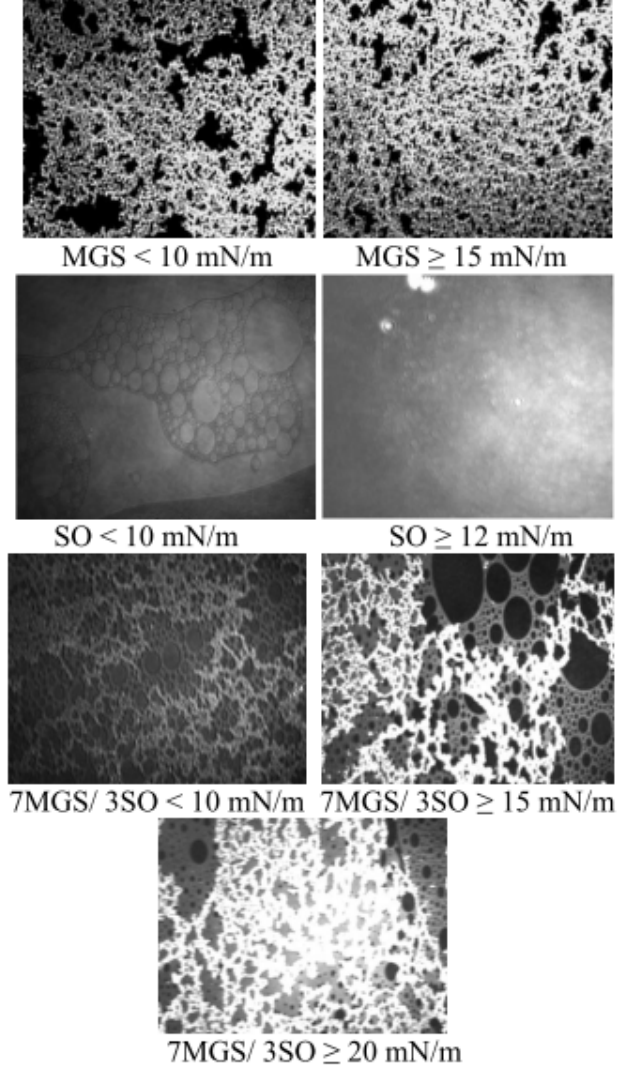
Figure 2. BAM images (500 μ m × 300 μ m) of MGS, SO and pseudobinary MGS/SO films.